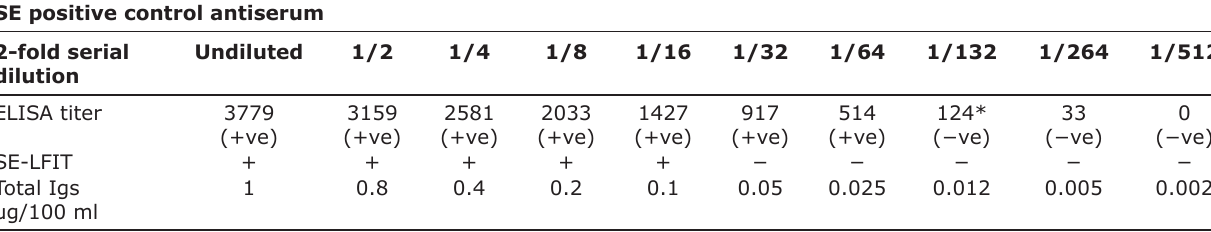
Table-3: The sensitivity test of SE-LFIT.